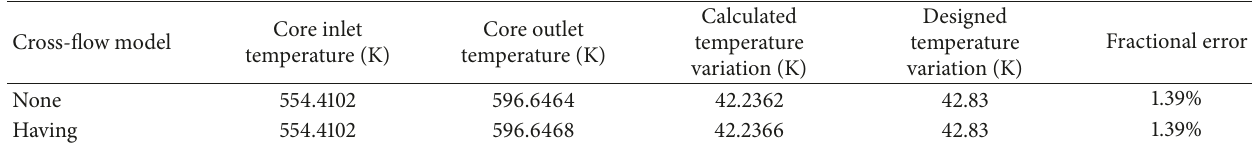
Table 17: The influence of cross-flow model on the coolant temperature variation.